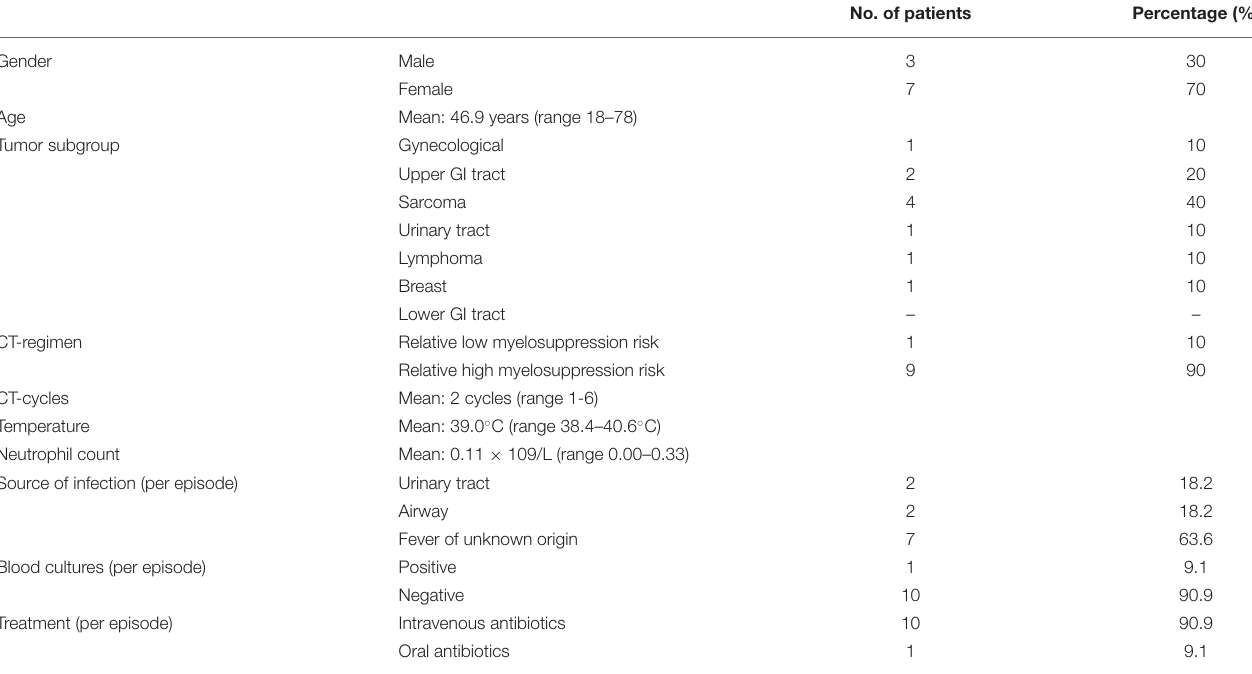
TABLE 4 | Characteristics of patients ( n = 10), in which 11 episodes of febrile neutropenia developed during chemotherapy